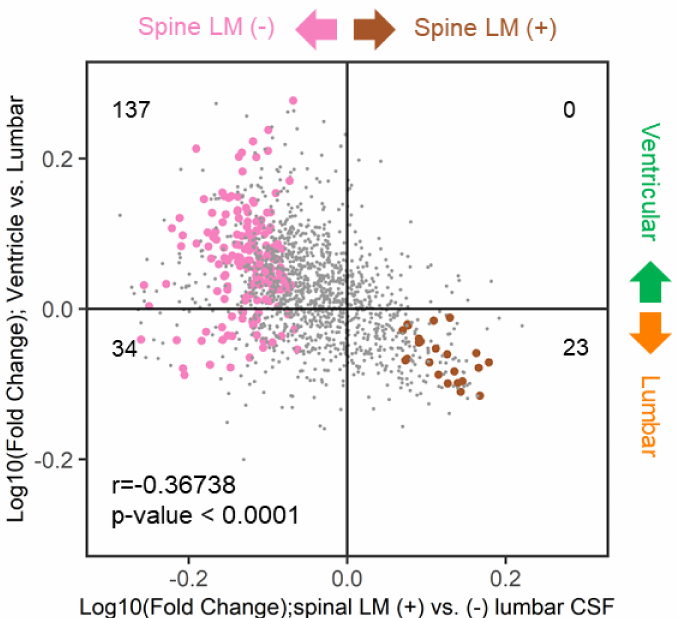
Figure 7. Volcano plot illustrating the similarity of proteins distribution between discriminative lumbar (over ventricular) and spinal LM (+) (over spinal LM ( − )) CSF samples. A single dot presents a single protein. X-axis: Log 10 (mean abundance of spinal LM (+) group/mean abundance of spinal LM ( − ) group). Y-axis: Log 10 (mean abundance of ventricle group/mean abundance of lumbar group). Proteins with 2-group t -test p -value < 0.05 are presented in pink or brown color dots. Pearson’s correlation coefficient was obtained using R (ver. 4.0.4). Pearson’s correlation coefficient r was calculated in R (ver.